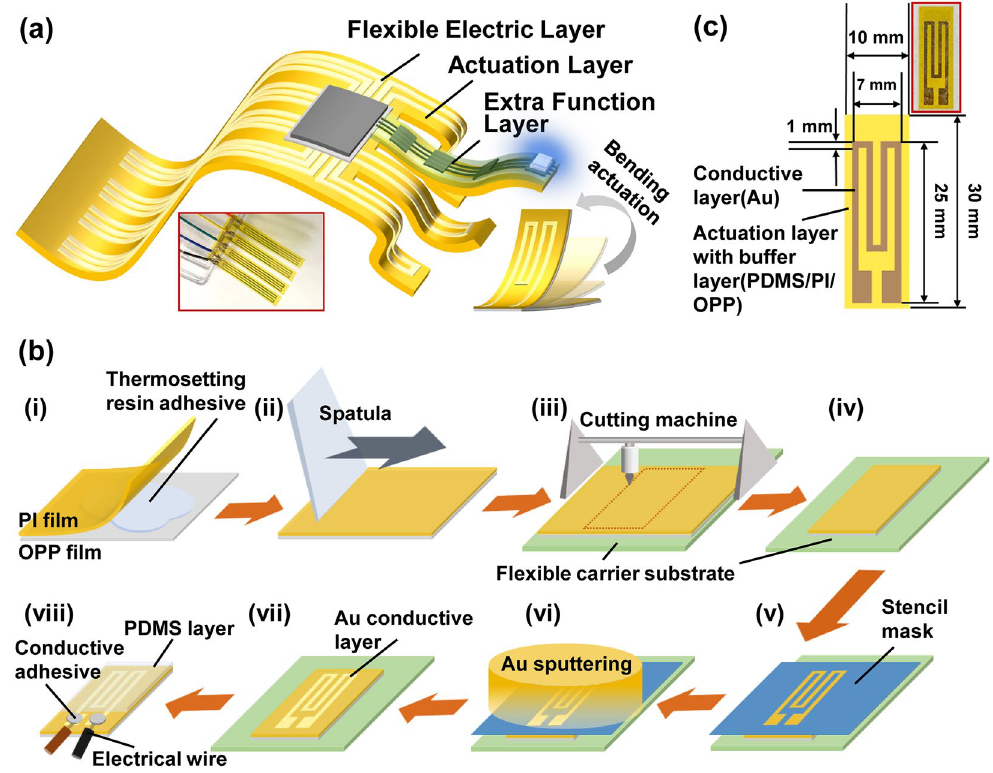
Figure 1. Concept of layered, flexible, film microrobot fabrication. ( a ) Schematics of layered film soft robot structure. ( b ) Schematic of monolithic fabrication process of layered film microrobot: (i, ii) Bonding of base films for forming bimorph actuator film; (iii) Cutting the outline of a film robot; (iv–vi) Arrangement of stenciled mask to robot outline and Au deposition by sputtering for electrical layer patterning; and (vii, viii) PDMS mechanical buffer layer coating and wiring. ( c ) Single-joint single-finger film robot design and photograph